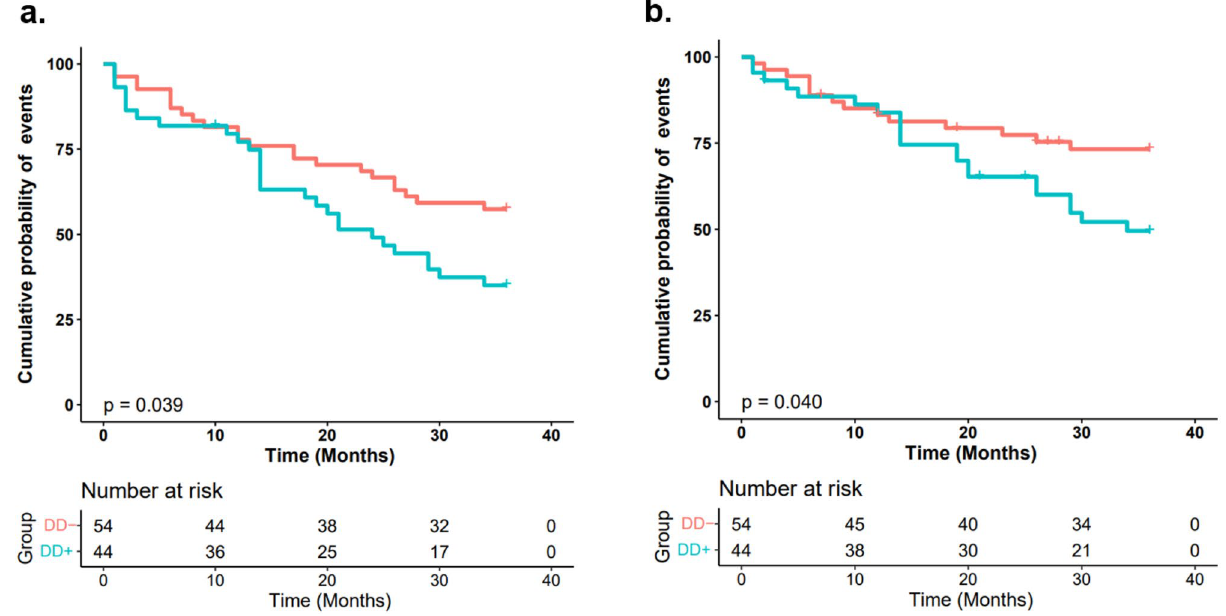
Figure 3. Kaplan–Meier analysis by log-rank test. ( a ) the endpoint was a composite of the first nonfatal CV event and all-cause mortality; ( b ) the endpoint was LSCEs; DD+: diaphragm dysfunction (blue line); DD−: normal diaphragm function (red line).